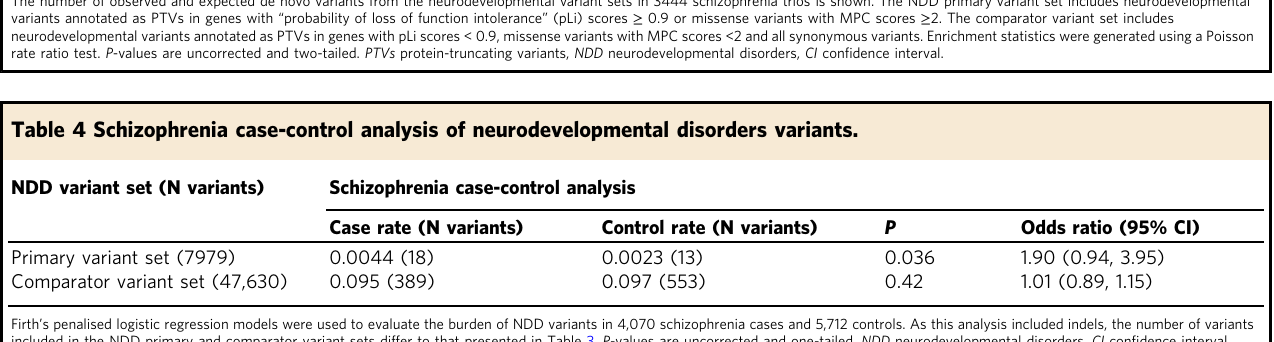
(Table 2). This ASD proband did not have intellectual disability (IQ of 92), but showed delayed age of walking 32 .